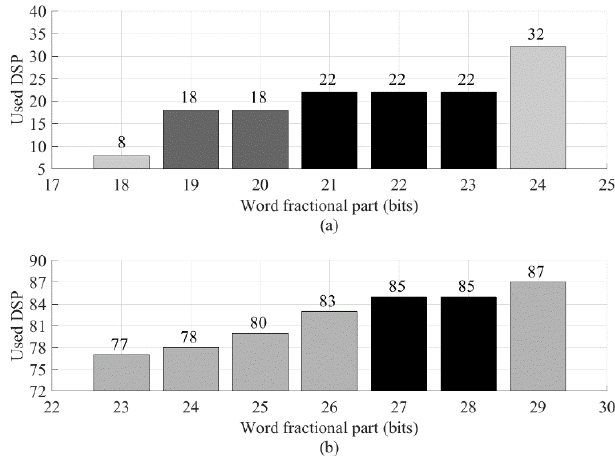
Fig. 7. Number of DSP cells needed to model IVGTT (a) and NPQ (b) MP systems with a particular number of bits for fractional part. The number of bits for the integer part of IVGTT system is always 12, while for NPQ system –